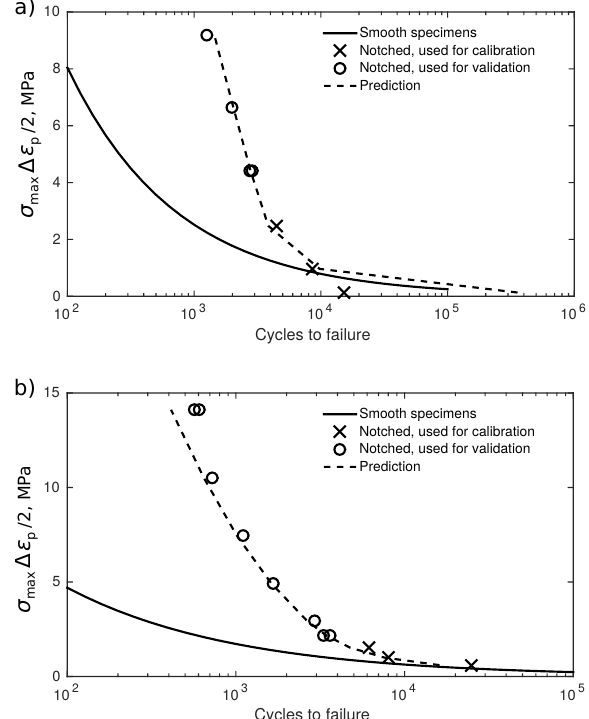
Figure 9. The modified SWT parameter, σ max ∆ ε p / 2, versus cycles to failure for smooth and notched spec- imens at: a) 450 °C and b) 550 °C. For the notched specimens, the data is plotted versus the notch root modified SWT parameter, σ max ( x = 0)∆ ε p ( x = 0) / 2, but the prediction has been made based on the mod- ified SWT parameter at the critical distance, r , i.e., σ max ( x = r )∆ ε p ( x = r ) /